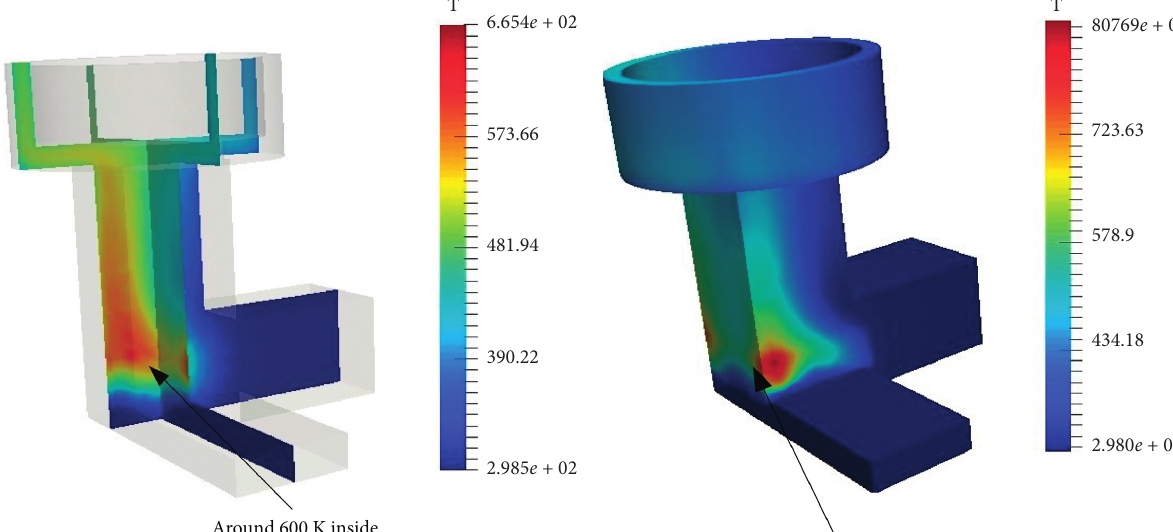
Figure 13: Temperature fields.